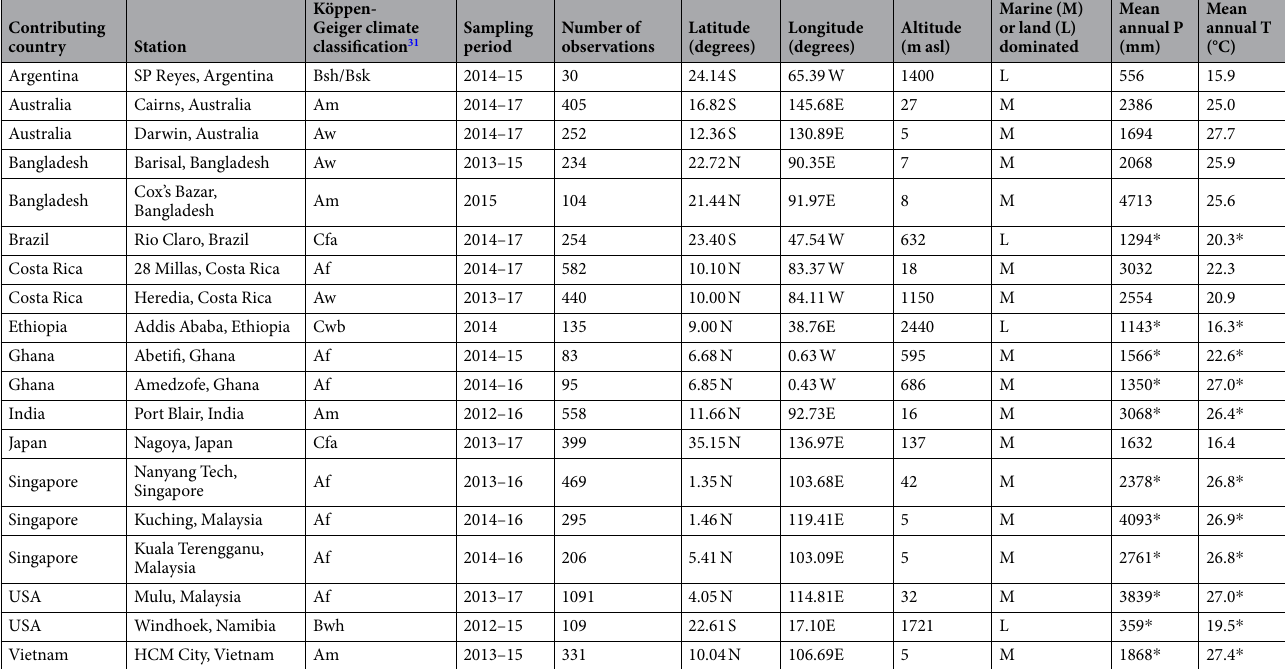
Table 1. Location and climate information for rainfall sampling stations. * Data from Climate-data.org where not supplied by site investigator.